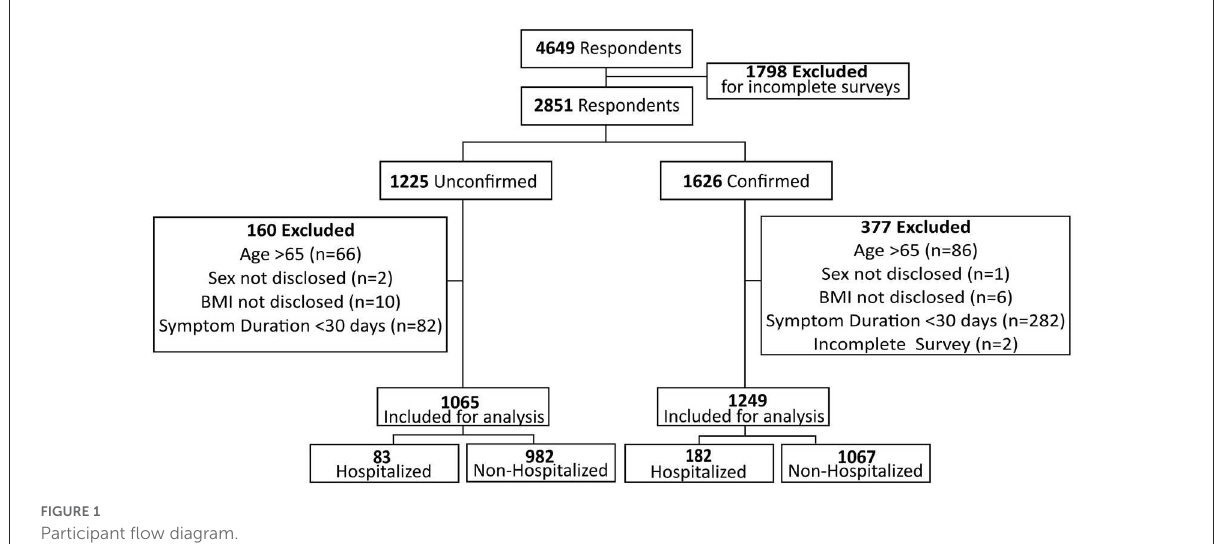
FIGURE1 Participant flow diagram.